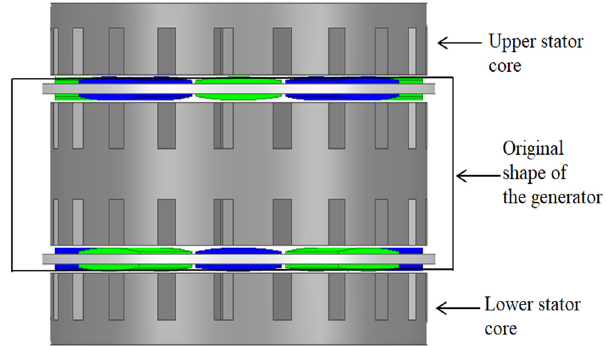
Figure 2. Modified shape of the original generator in Figure 1.